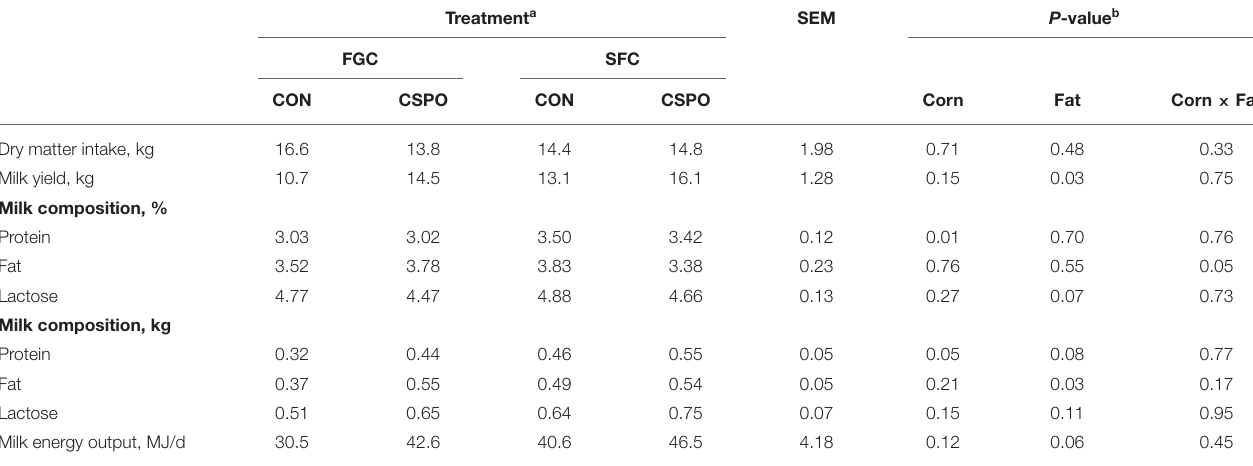
TABLE 5 | Performance parameters of dairy cows receiving the treatment diets (Experiment 2). Treatment a SEM P -value b FGC SFC CSPO CON CSPO Corn Fat Corn × Fat